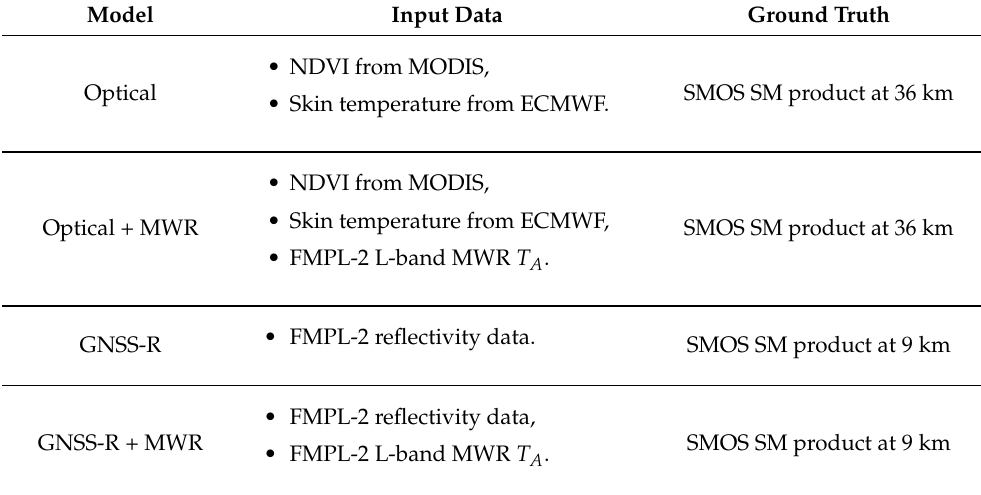
Table 1. Summary of the ANN based models implemented to estimate